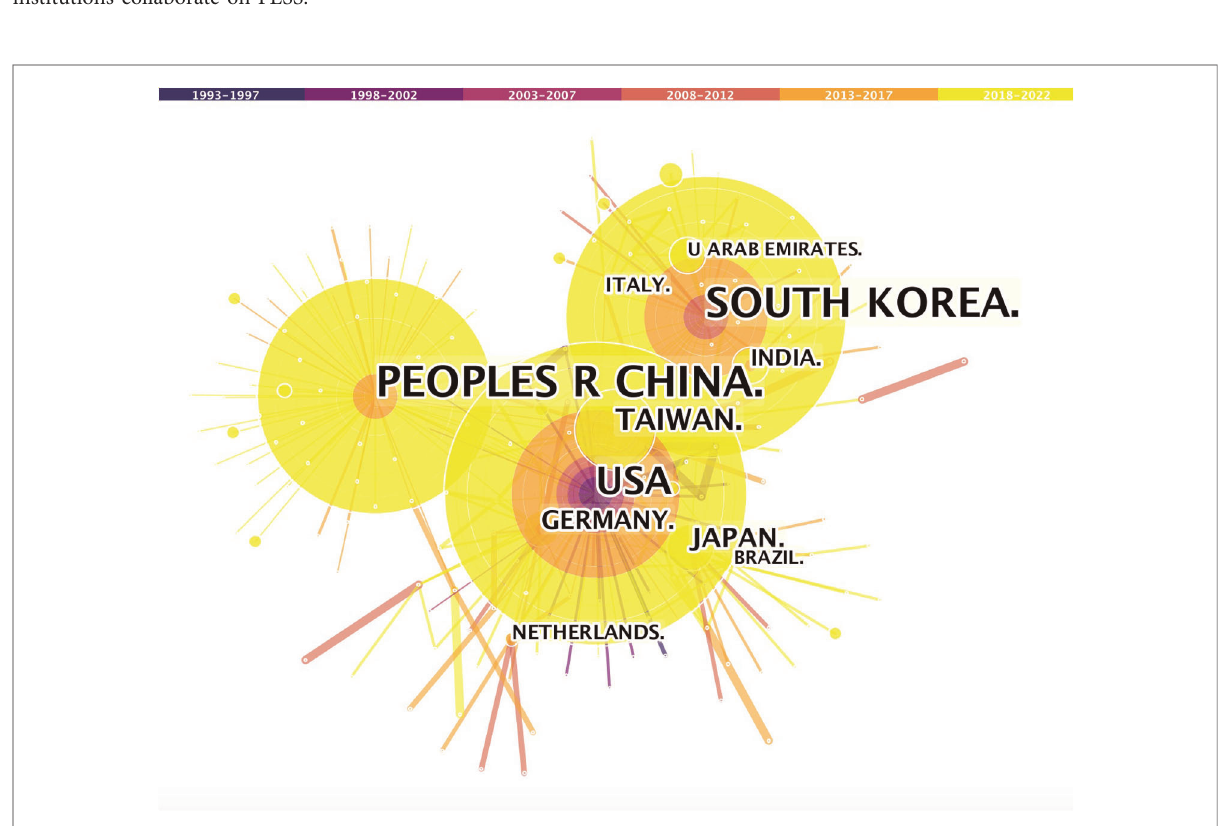
FIGURE 2 Co-operation of productive